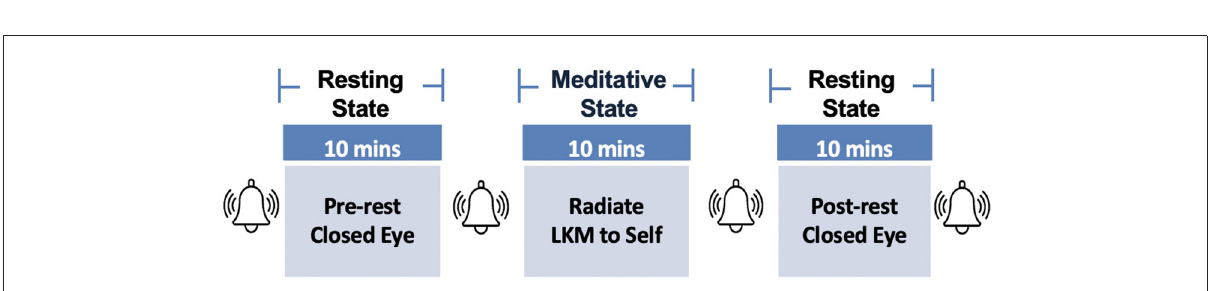
FIGURE2 Experimental paradigm constructed of pre-resting, LKM, and post-resting state.